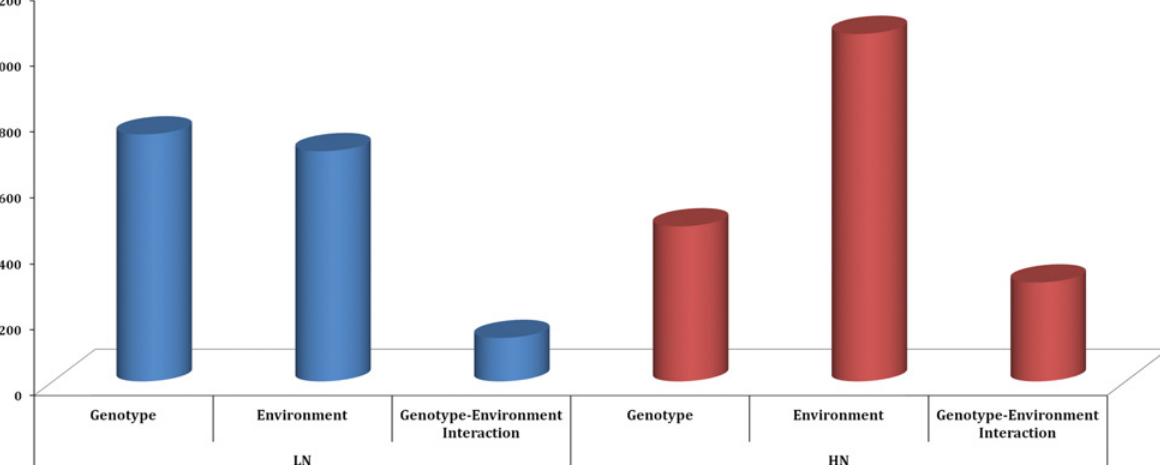
Fig 2. Genotype, environment, and genotype – environment interaction effects in wine yeast strains. Differentially expressed genes at each nitrogen regime studied (LN and HN), identified using two-way ANOVA. The number of genes significantly affected by genotype (strain), by environment (fermentation stage) and by the interaction between both factors is represented with bars. The selection of genes showing differential expression (with a significant effect of the different factors) was defined at FDR < 0.05 using the Benjamini and Hochberg correction.